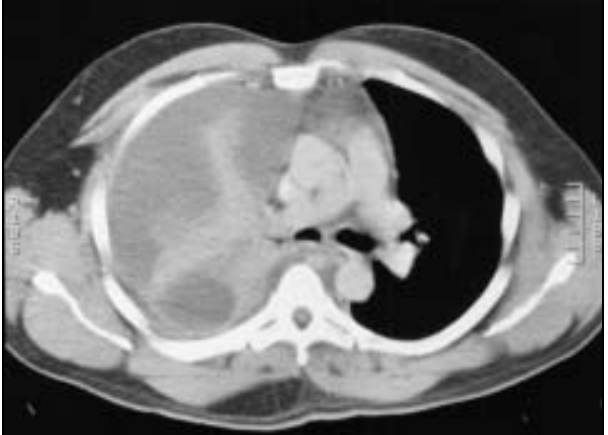
Figure 1) Computed tomography scan of the thorax performed the same day highlights the following: massive fluid accumulation in the right hemithorax and extending across the mediastinum (as not- ed by the dark shade); impressive compression of the lung tissue (noted by the light shade); and shift of the mediastinum, best seen by the displacement of the carina from